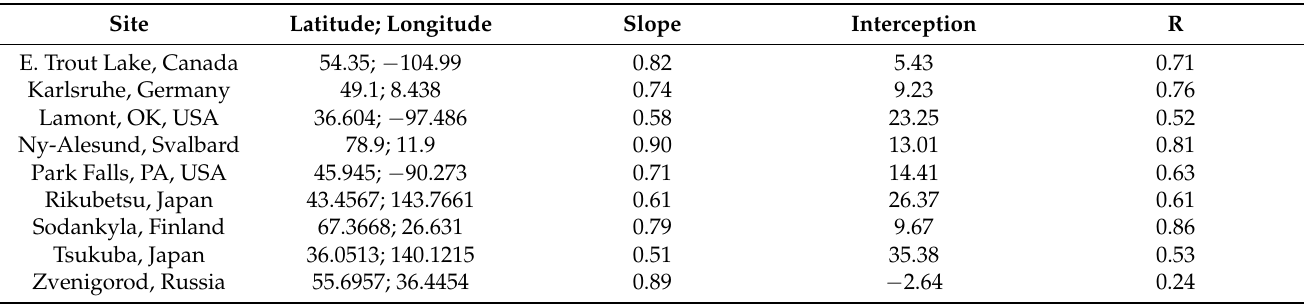
Table 1. Validation sites, locations, and parameters of linear